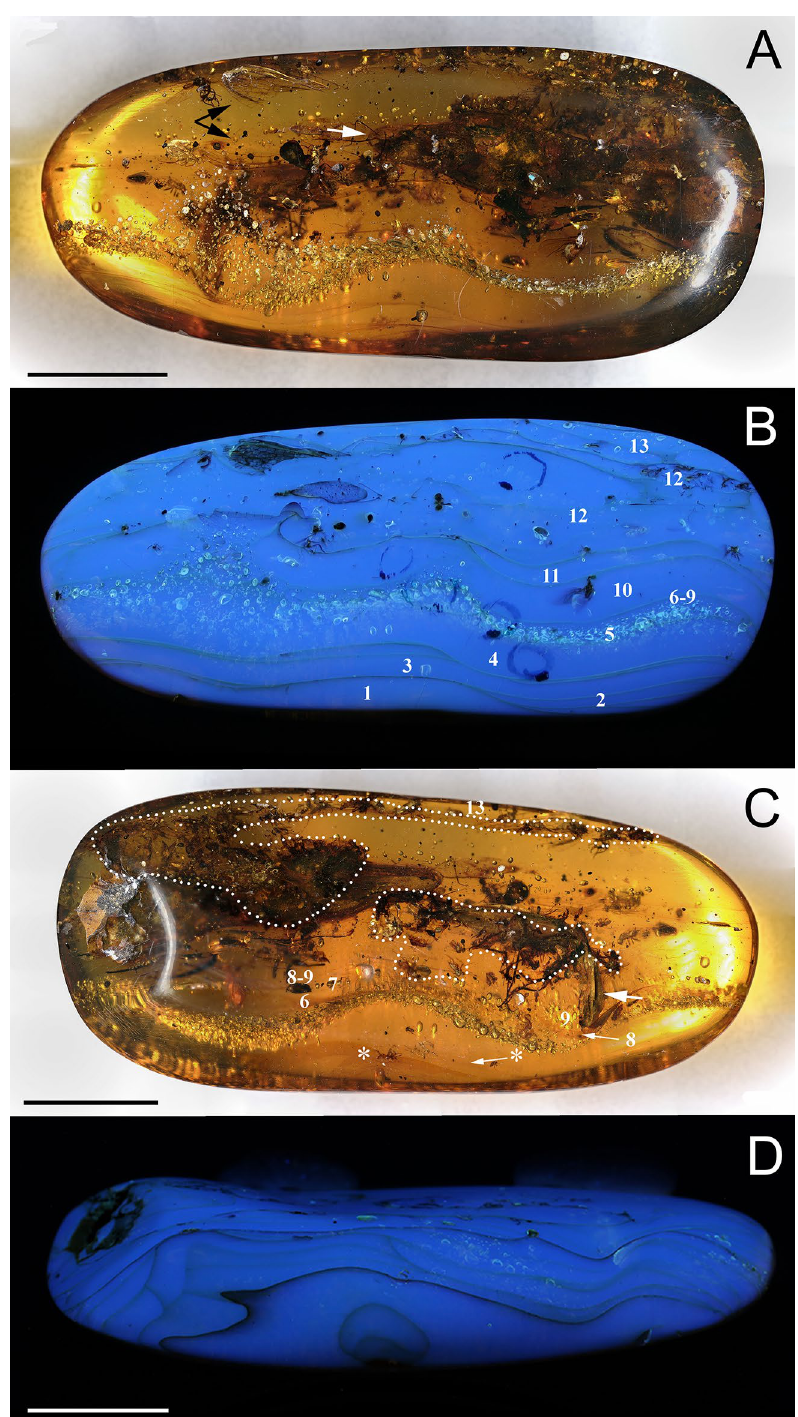
Figure 4. Piece GRS-Ref-28627 photographed with visible light and UV light. ( A , B ) Layers with their numeration (see Fig. 2) and main syninclusions s.l. as observed in the piece side A (in A: the two black arrows indicate the large portions of a neuropteran individual and white arrow indicates the tip of the rostrum of the Oculudentavis naga holotype). ( C ) Layers with their numeration (see Fig. 2) and bioinclusions as observed in the piece side B; the two areas preserved of the top surface of layer 12 (surface of interest) are marked with dotted lines (white arrow indicates the head of the large beetle, most likely an Elateroidea; asterisks indicate the darker top surfaces of the layers 1 and 2). ( D ) UV light photograph of the piece in lateral view showing the limits of some layers. Images ( A ) and ( B ) to the same scale and orientation. Scale bars 1